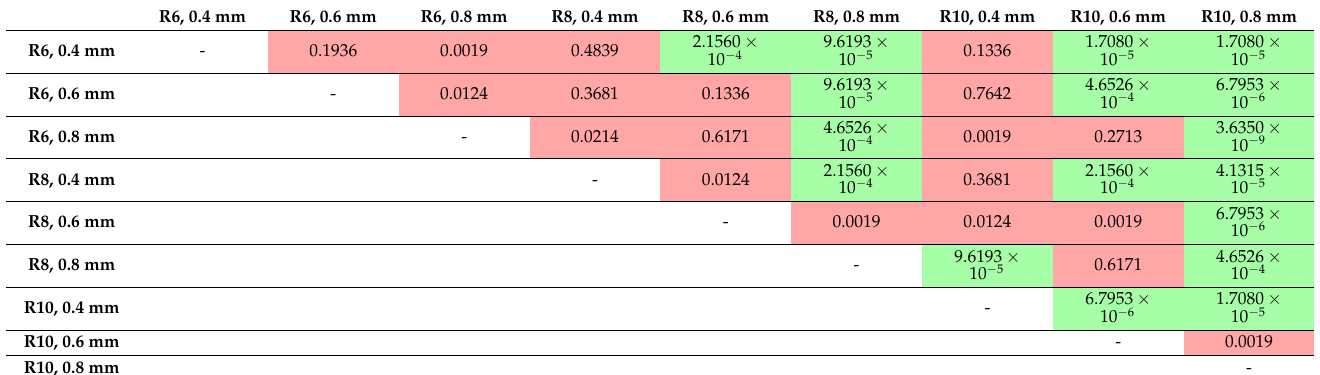
Table 2. p -Values obtained by sign test for all glass images. Green cells are those that have a statistically significant difference while red ones are those that have no statistically significant difference. Threshold used in Bonferroni correction is 0.05/36 =